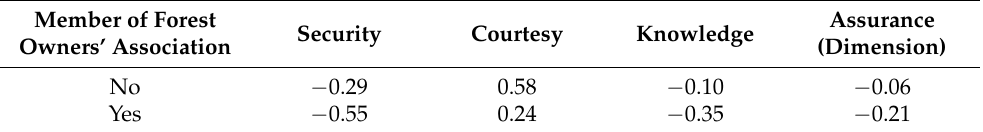
Table 9. Average service quality score for members and non-members of forest owners’ associations. Differences between groups are significant for courtesy and assurance (dimension) ( p <